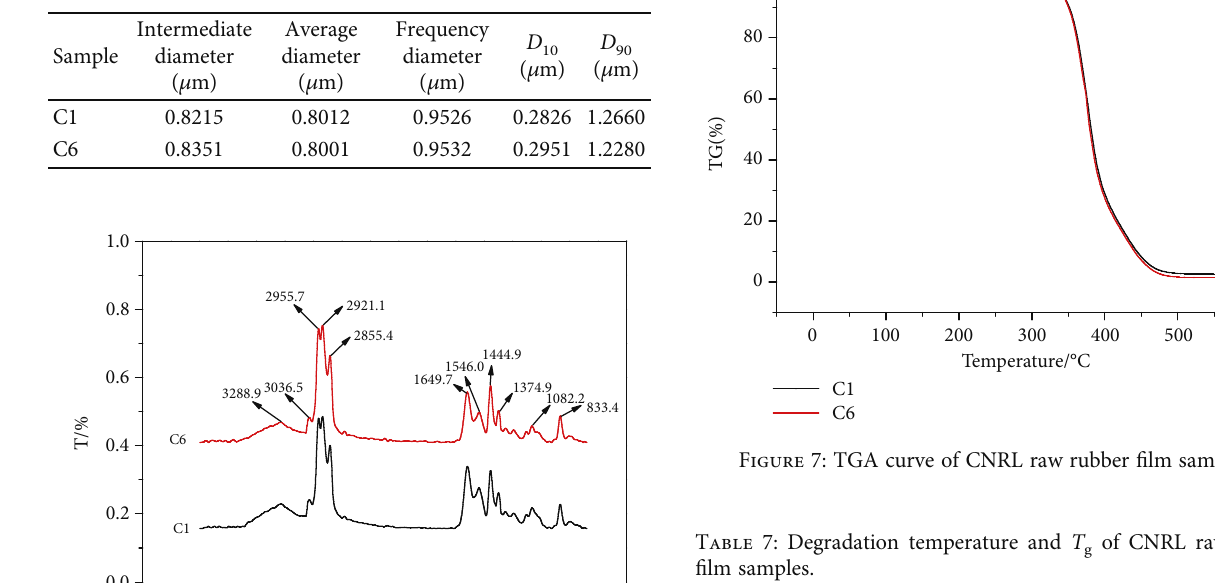
Table 6: Characteristics of particle size distributions of CNRL rubber particles.